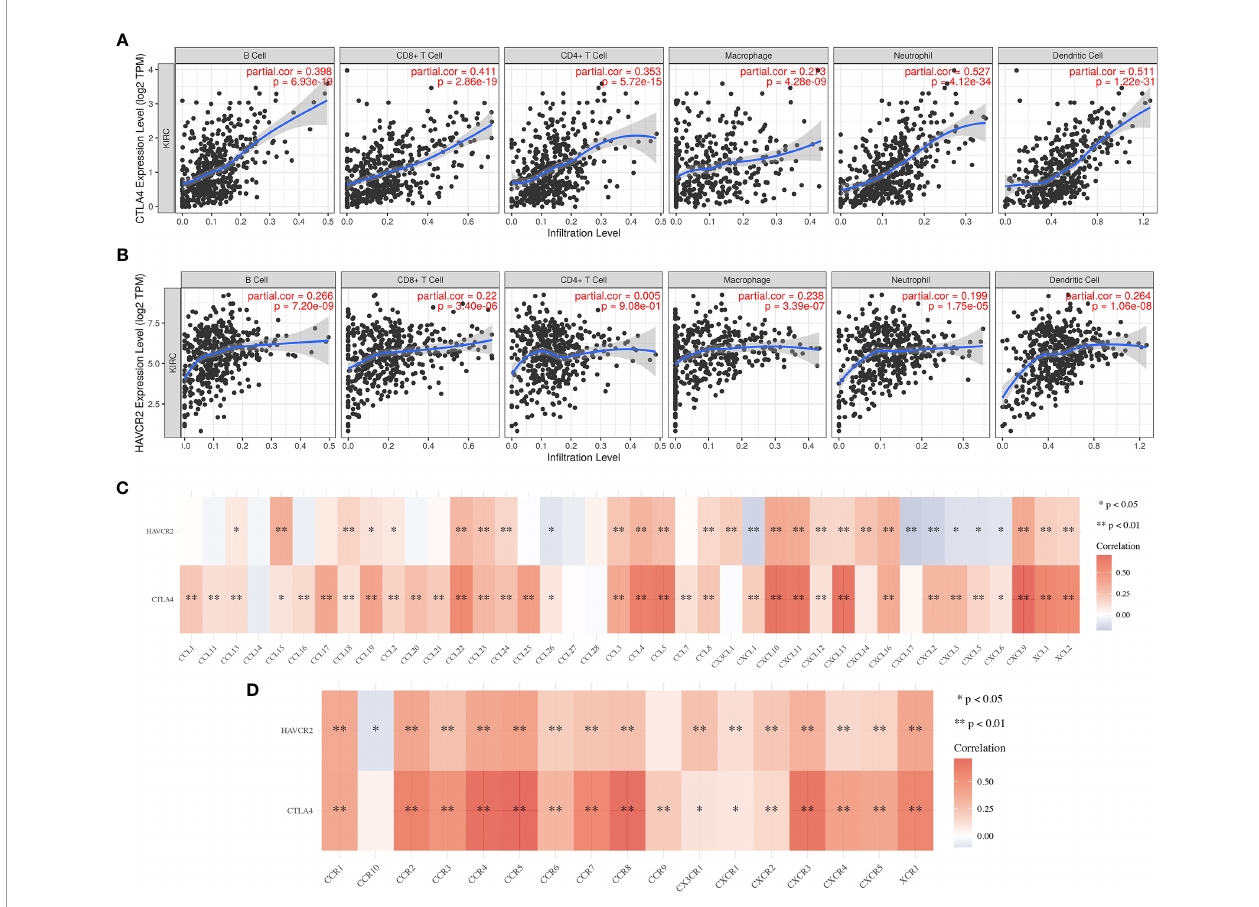
FIGURE 7 | The correlation between immune checkpoints and immune in fi ltration in KIRC(TIMER). (A, B) The correlation between the expression of CTLA4 and HAVCR2 and the abundance of CD8+ T cells, CD4+ T cells, Macrophage, Neutrophils and Dendritic cells. (C, D) The correlation between SCNA of CTLA4 and HAVCR2 and immune cell in fi ltration. SCNA, somatic copy number alterations; *P < 0.05, **P <